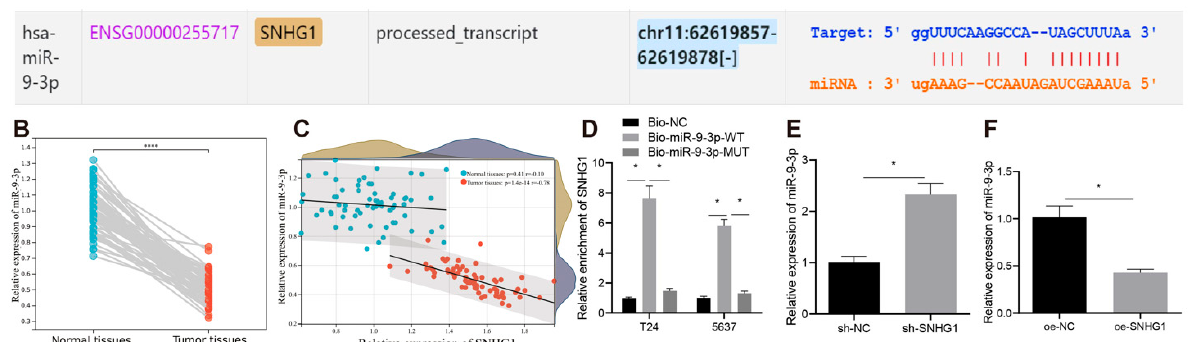
Figure 5. SNHG1 binds to and downregulates miR-9-3p. ( A ) starBase: http://starbase.sysu.edu.cn/ (5 July 2021) website predicting that SNHG1 bound to miR-9-3p. ( B ) qRT-PCR detecting the expression of miR-9-3p in 40 bladder cancer and adjacent normal tissues. ( C ) Correlation analysis of the expression of SNHG1 and miR-9-3p. ( D ) RNA pull-down assay detecting the binding relationship between SNHG1 and miR-9-3p. ( E ) qRT-PCR detection of the expression of miR-9-3p after silencing SNHG1 in T24 cells. ( F ) qRT-PCR detection of the expression of miR-9-3p after overexpressing SNHG1 in 5637 cells. * p < 0.05. The experiment was repeated three times. Data were presented as mean ± standard deviation and compared by t test or one-way analysis of variance (ANOVA), followed by Tukey’s post hoc test.